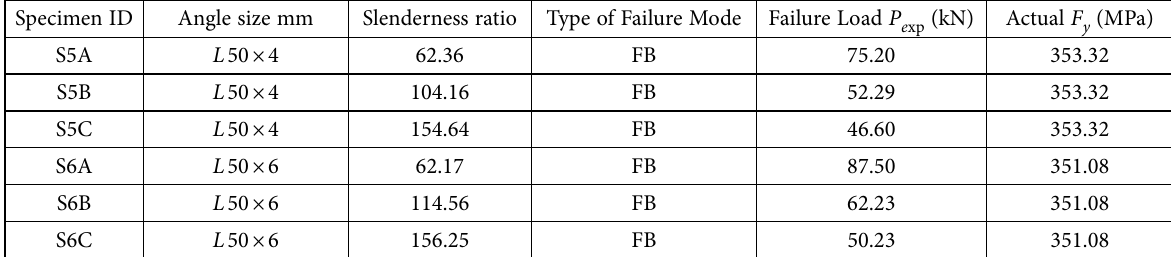
Table 8. Experimental test result for two bolted angle specimens